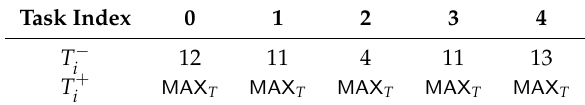
Table 1. The feasible range of each task period after applying static